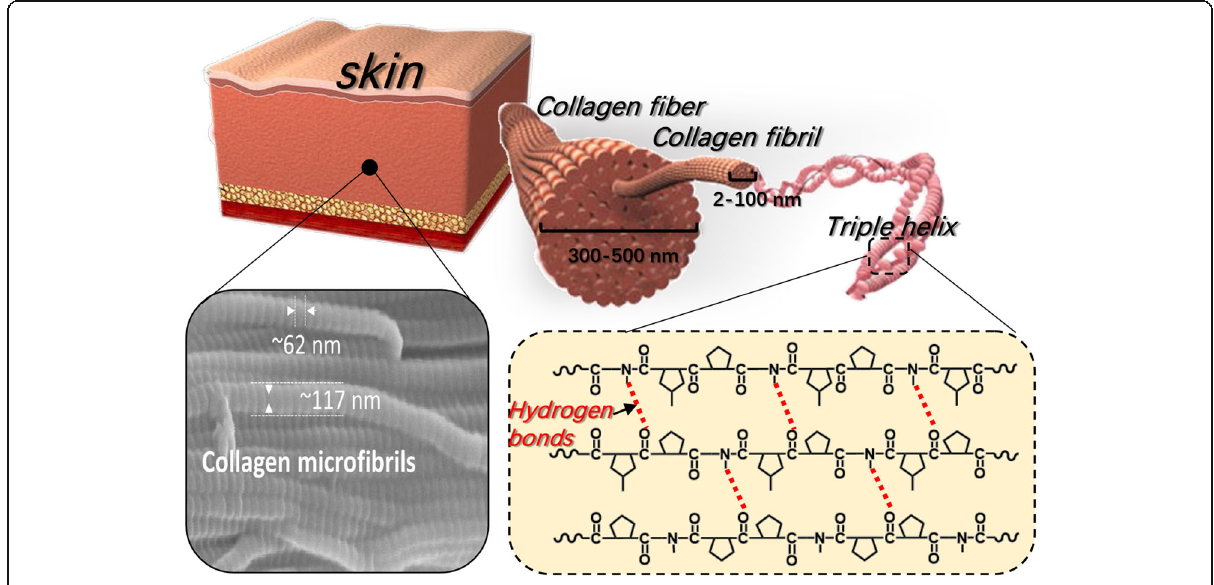
Fig. 2 Hierarchical structure of SC from triple helix to fiber network